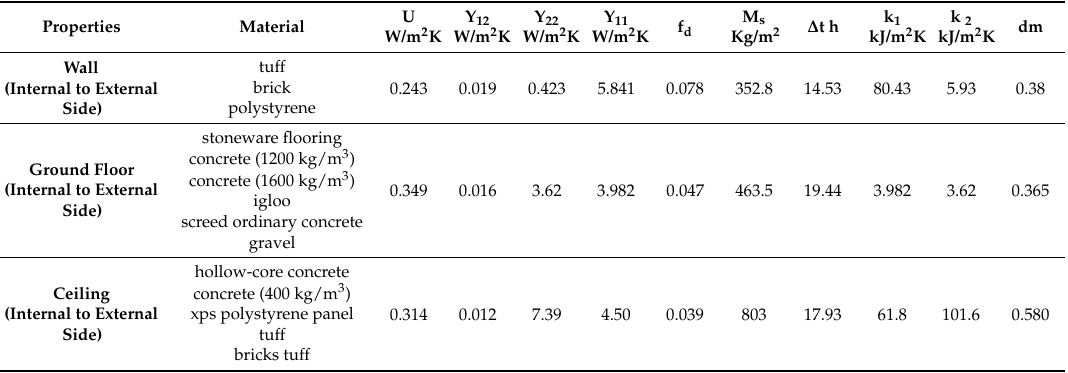
Table 3. Envelope characteristics.